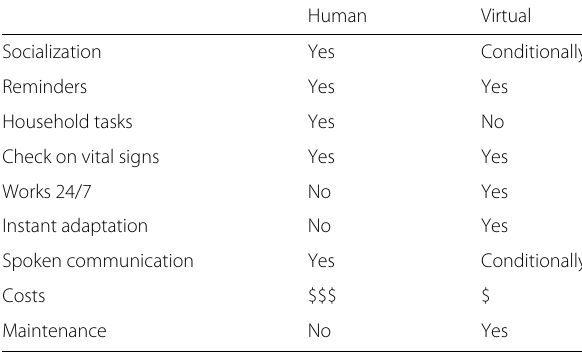
Table 1 Comparison of a professional personal assistant and a virtual